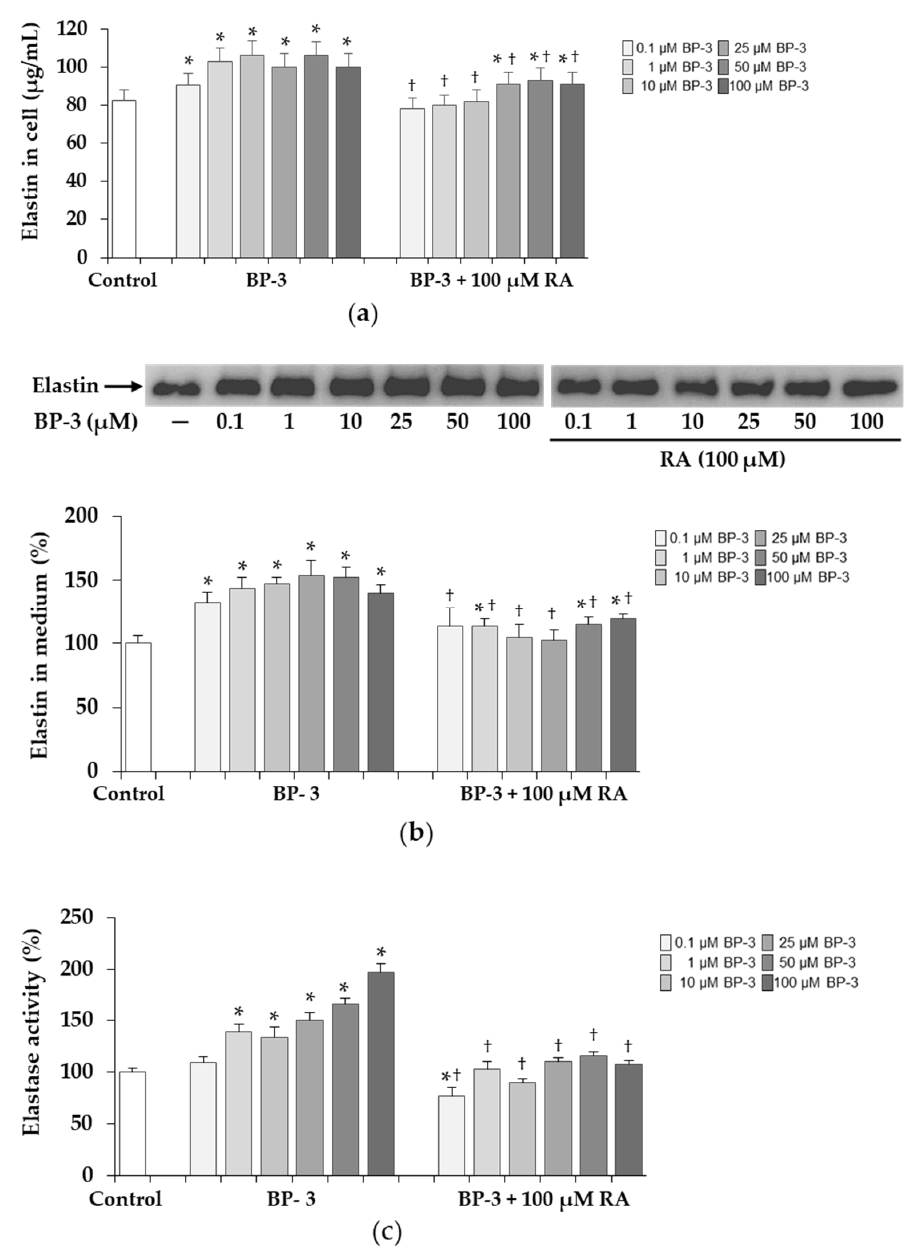
Figure 9. The influence of benzophenone-3 (BP-3) alone and in combination with rosmarinic acid (RA) on the content of intracellular elastin determined by Elastin Assay—Fastin™ Elastin kit (Biocolor Ltd.) ( a ) and the expression of secreted elastin determined by Western blot and densitometry ( b ), and elastase activity measured with the synthetic substrate N-succinyl-tri-alanyl-p-nitroanilide in the culture medium of fibroblasts ( c ). The data are expressed as a percentage of the control sample assumed as 100% ( b , c ). Values represent the mean ± SD of three experiments; * p < 0.05 vs. control (untreated cells); † p < 0.05 vs. respective samples treated with BP-3 alone.